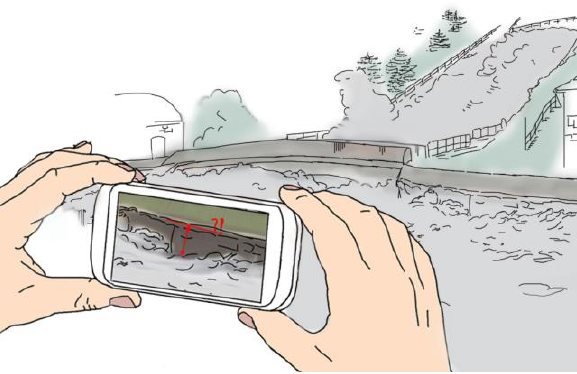
Figure 1. Schematic use case of water level determination using hand-held